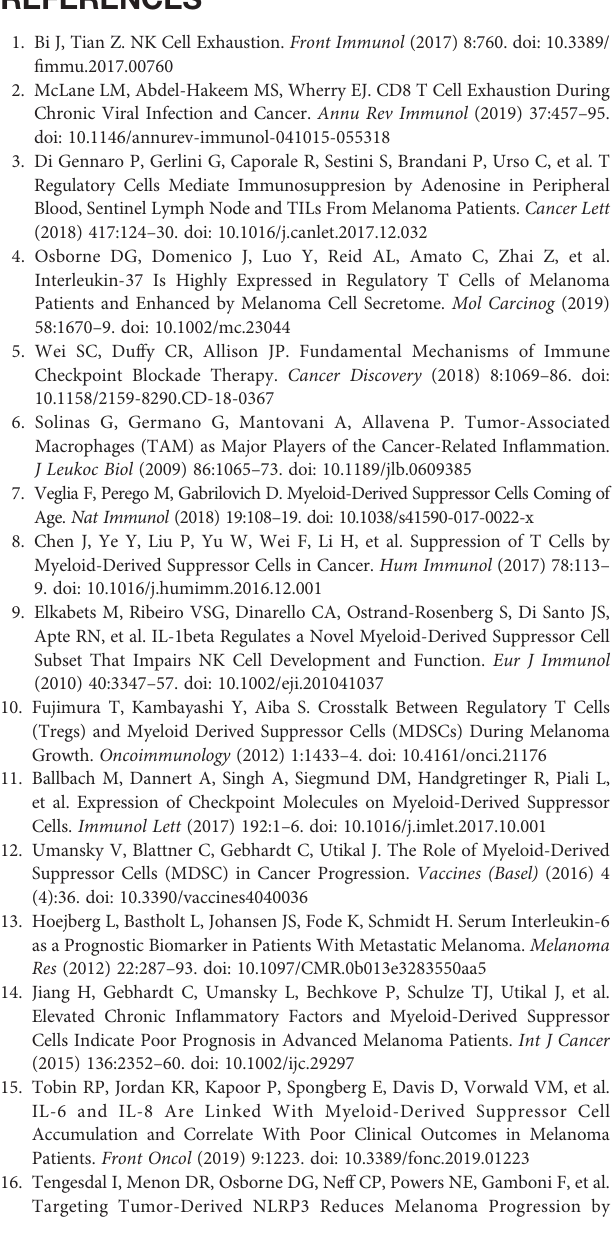
(N=363). (D) Correlation between of SOCS3 and IL-1 b expression in human cutaneous melanoma (SKCM) TCGA datasets (N=363). Supplementary Figure 3 | FACs gating strategy depicting PMN-MDSCs populations that were isolated bone marrow of tumor-bearing mice. Supplementary Figure 4 | Mice were implanted with B16F10 and treated with salinecontrol(Vehicle)orAZD1480(AZD1480),onday15PMN-MDSCswereisolated from bone marrow and spleen. (A) Mean ± SEM of relative mRNA expression of Pdcd1l1 , Arg1, Il10 and Tgfb1 fromPMN-MDSCsisolated from bone marrowofmice described above (N=2, pooled from 4 mice/group. 2 independent experiments). (B) Mean ± SEM of relative mRNA expression of Pdcd1l1 , Arg1, Il10 and Tgfb1